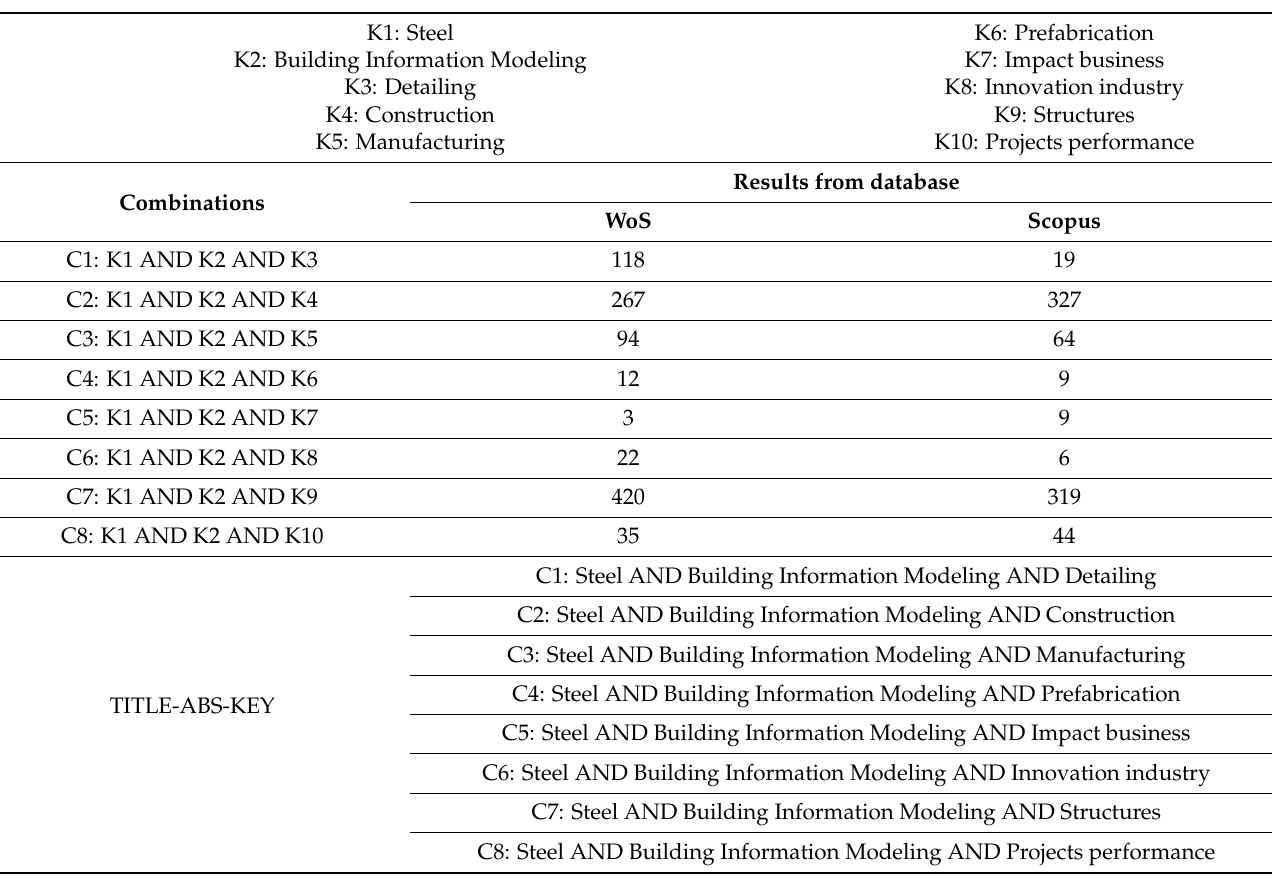
Table 2. Keyword combinations for BIM practices used in the SLR